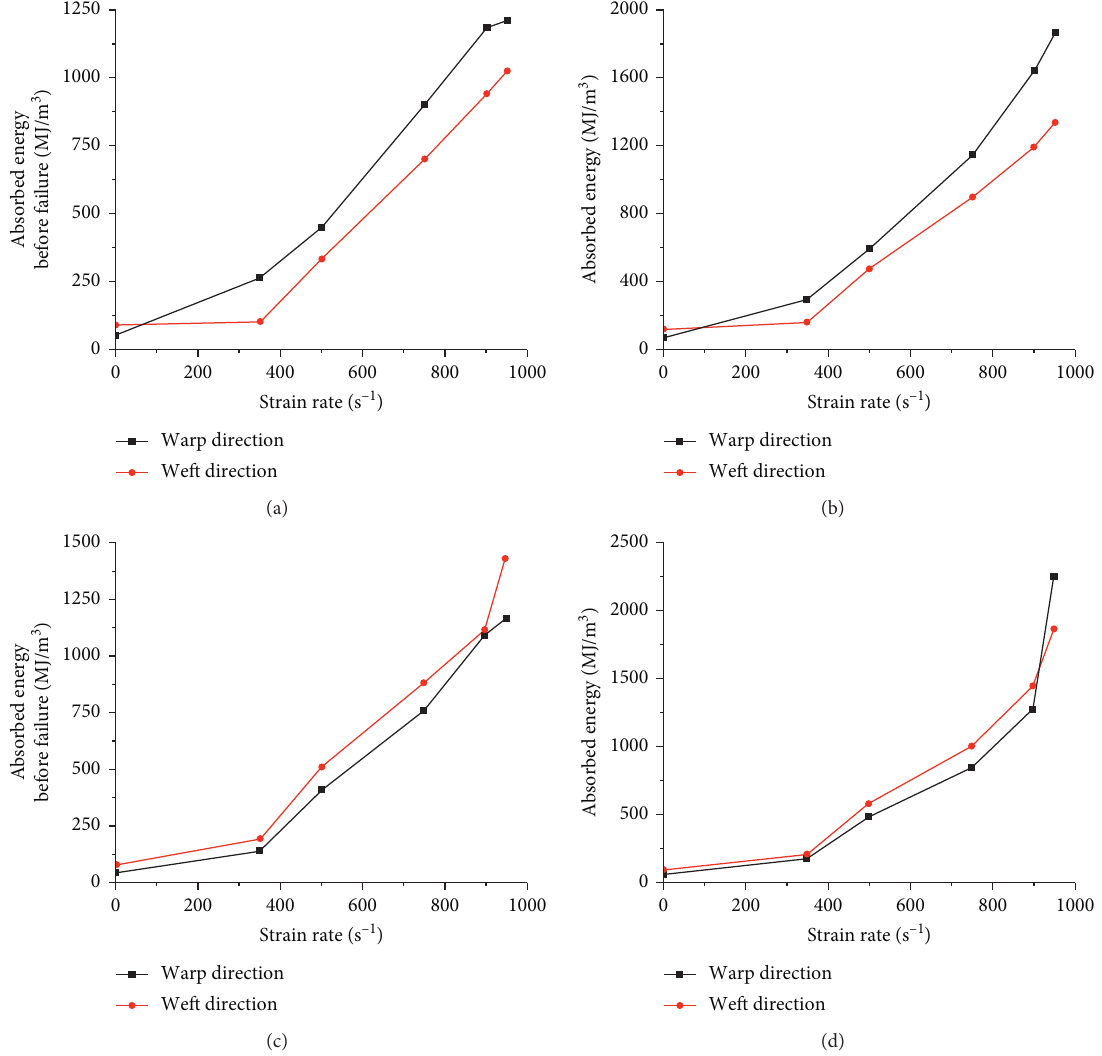
Figure 9: Energy absorption under different strain rates. (a) Energy absorption before failure (XYD). (b) Energy absorption after failure (XYD). (c) Energy absorption before failure (Ferrari). (d) Energy absorption after failure